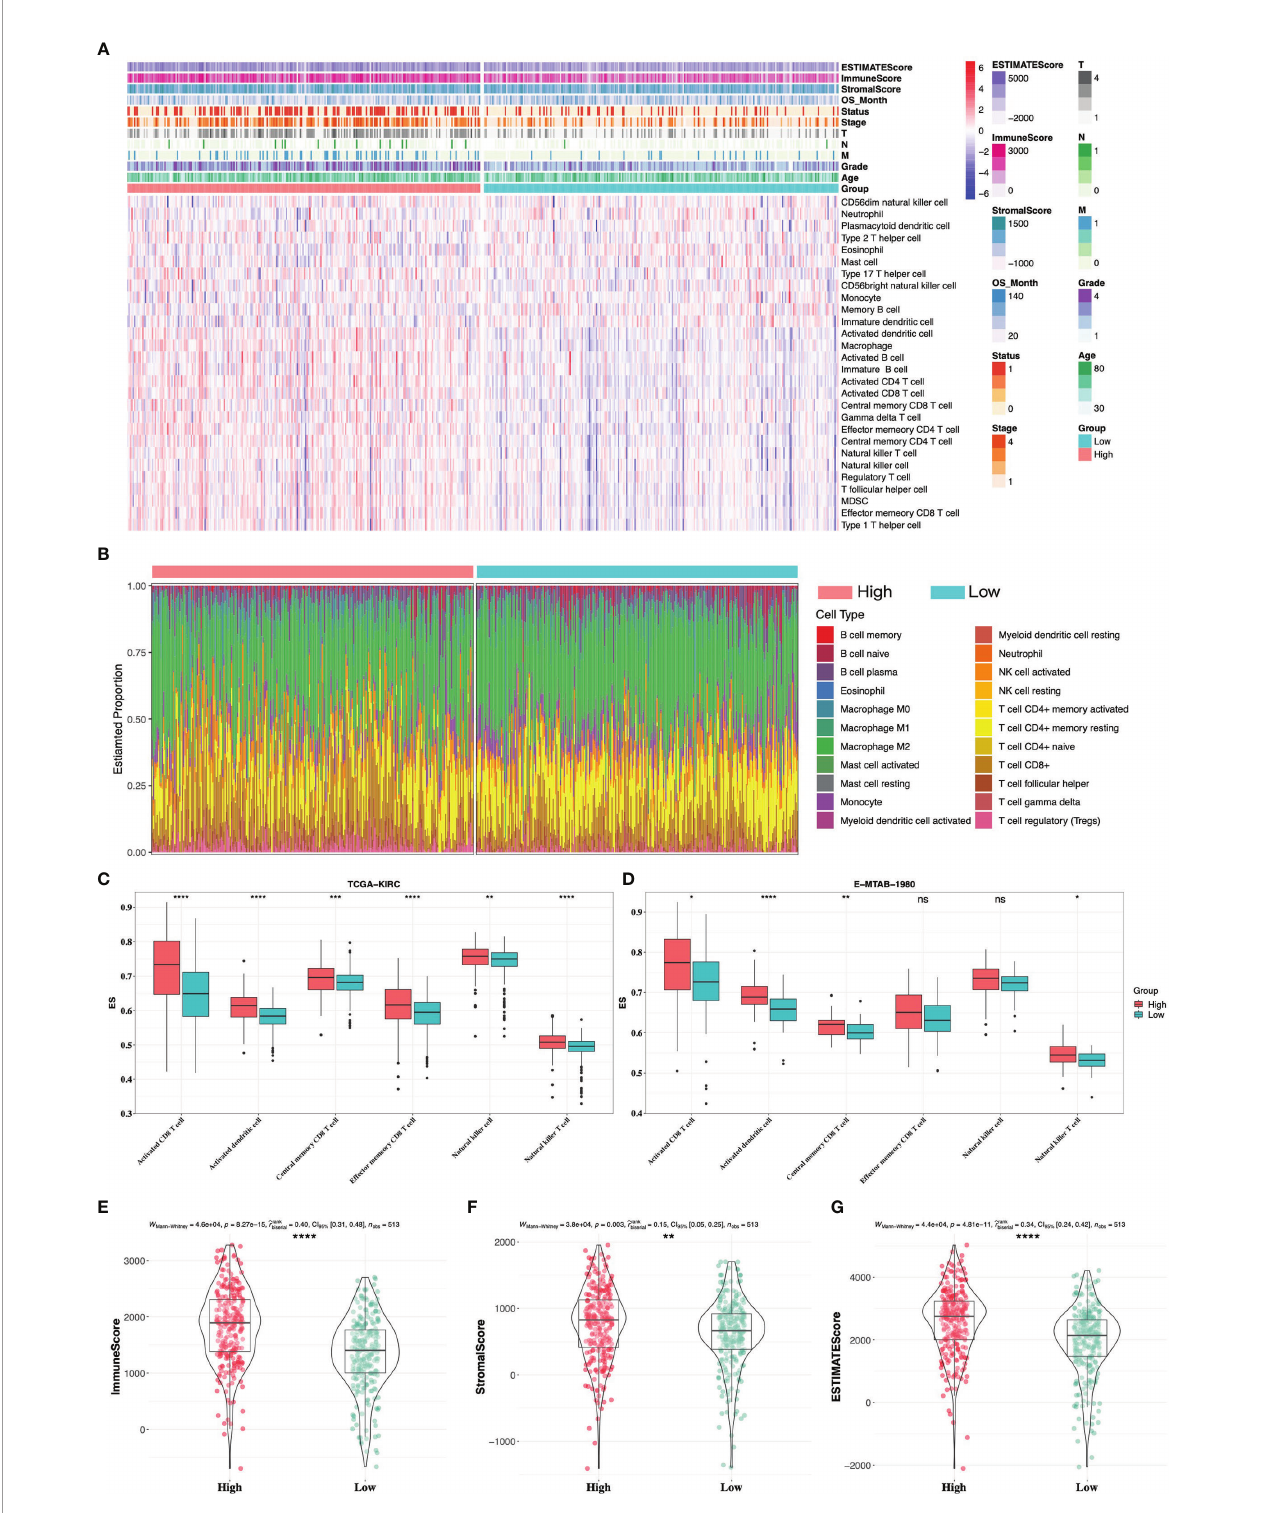
FIGURE 7 | Immune in fi ltrate landscape of high- and low-risk groups. (A) The landscape of immune in fi ltrates and clinical phenotypes between high- and low-risk groups. (B) The relative proportion of 22 immune cells in high- and low-risk groups by CIBERSORT analysis. Antitumor-related immune cells between high- and low- risk groups in TCGA-KIRC cohort (C) and E-MTAB-1980 cohort (D) . (E – G) ESTIMATE analysis between high- and low-risk groups in TCGA-KIRC cohort. * 0.01 < p < 0.05; ** 0.001 < p < 0.01; *** 0.0001 < p < 0.001; ****p < 0.0001; ns no signi fi